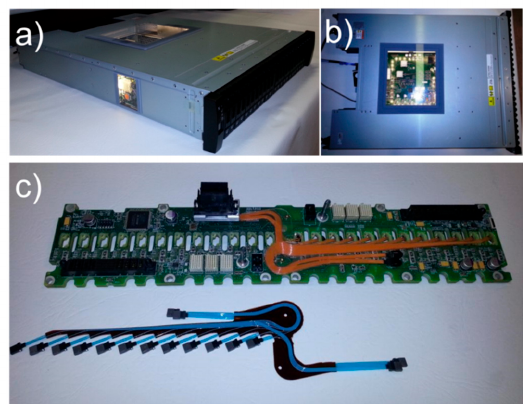
Figure 17. PhoxTest03.01 data storage platform: ( a ) Fully populated enclosure in operation, ( b ) top view of the enclosure, ( c ) electro-optical midplane with fiber flexplane.